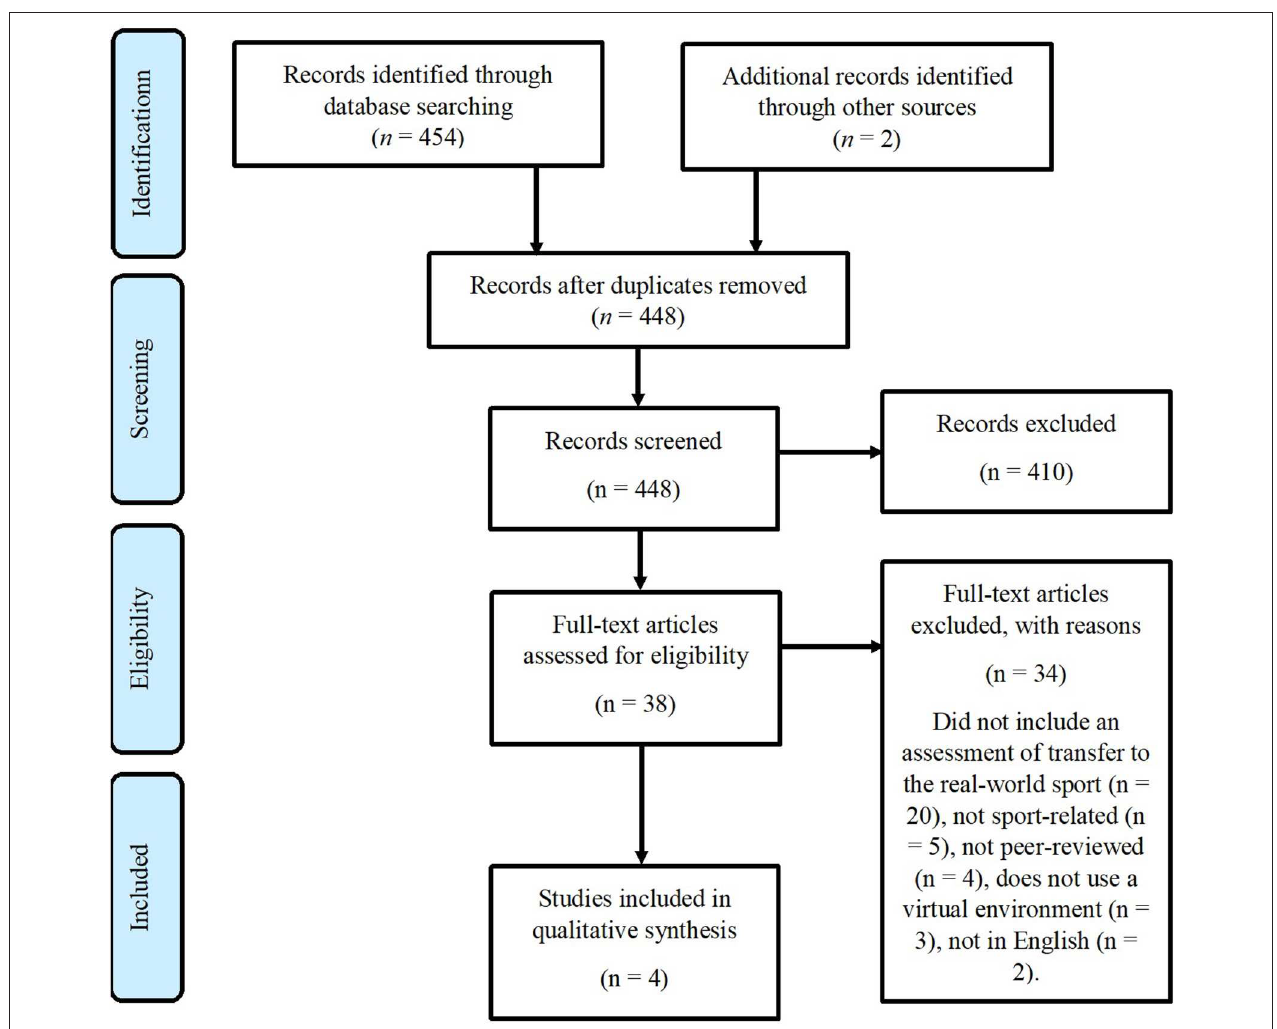
FIGURE 1 | The article selection and screening process using the PRISMA flow diagram (Liberati et al., 2009). Databases searched included PsycINFO, SportDiscus via EBSCOhost and IEEE Explore.